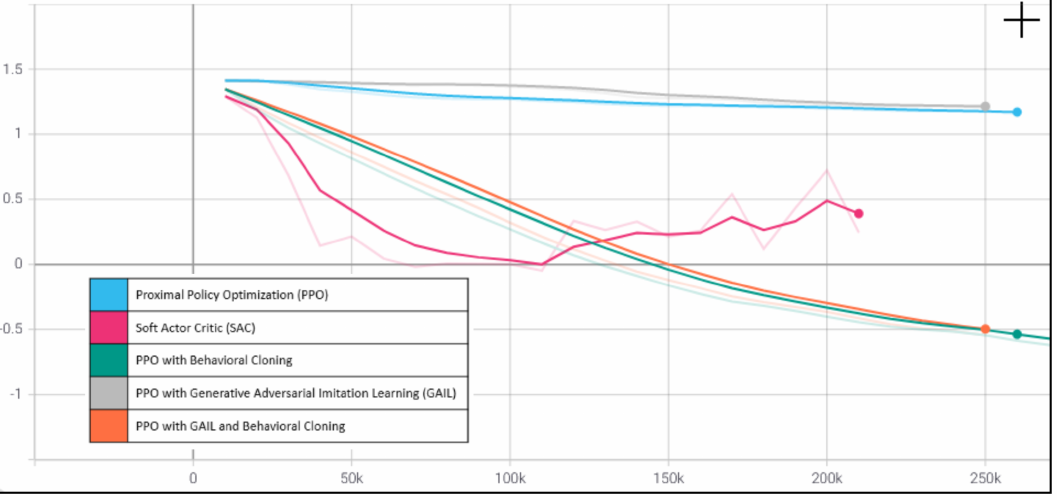
Figure 20. Simulation runs vs.